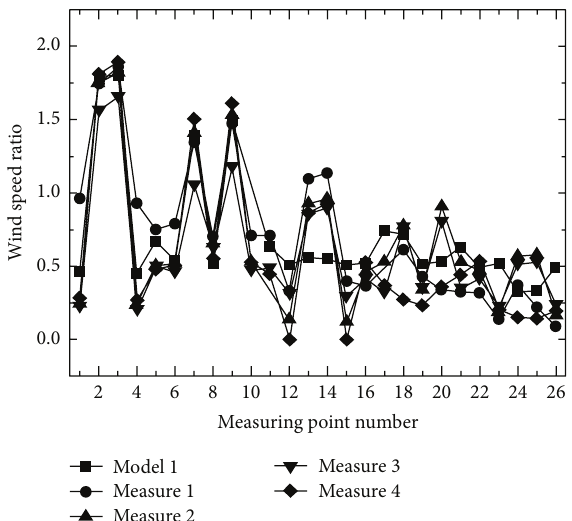
Figure 9: Distribution of the wind speed ratios at each measuring point based on the methods.